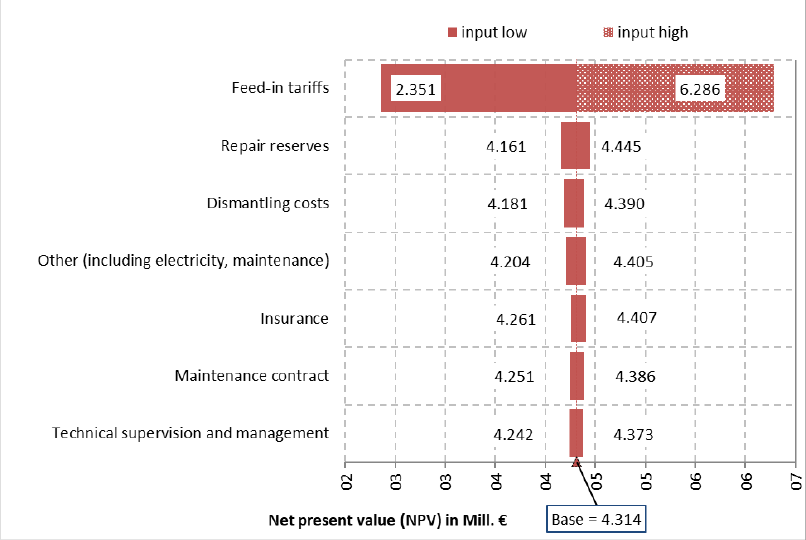
Figure 9. Tornado diagram with the relevance of the most important factors influencing the net present value (NPV) of a 4.8 MW wind turbine plant; stochastic simulation with 10,000 repetitions with @RISK. Source: own calculations.